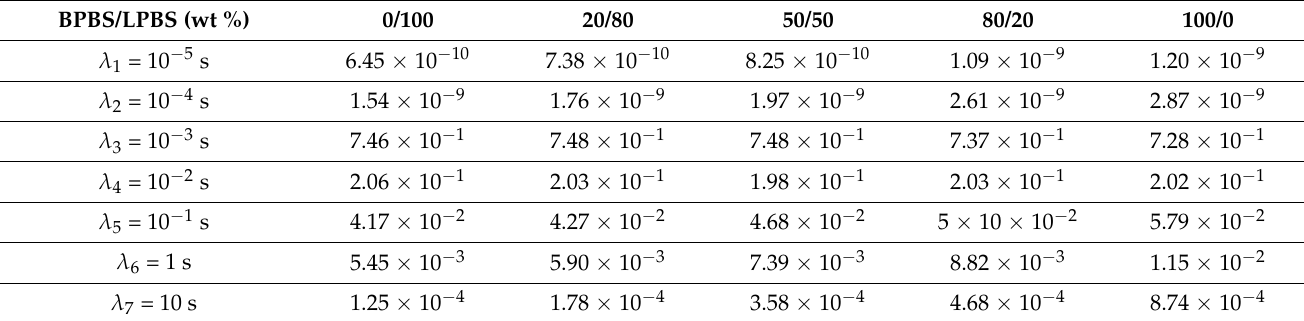
Table 6. Weighted relaxation strengths from the Generalized Maxwell Model (GMM) for BPBS, LPBS, and their blends at 150 ◦ C.